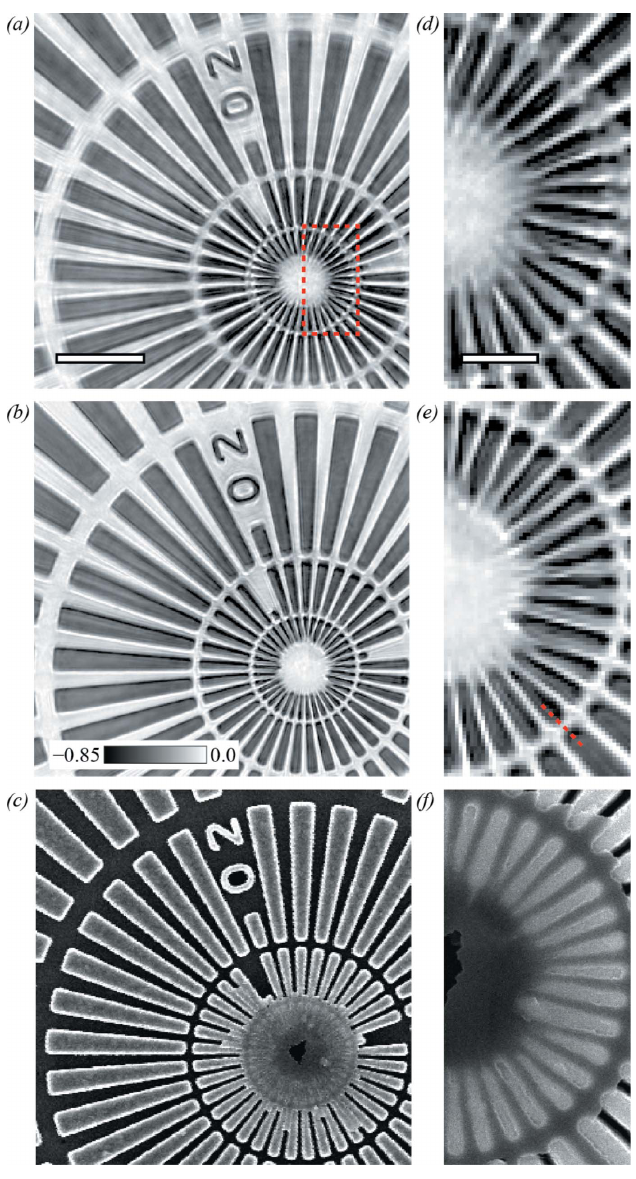
Figure 3 SXDM phase-contrast images of a test pattern for ( a ) externally triggered (ET) and ( b ) free-run (FR) data collection with interpolated positions. ( c ) An SEM image of the centre of the test pattern. Insets ( d )–( f ) are taken from the area depicted by the red box in panel ( a ), showing that FR data collection allows higher quality reconstruction of the finest details in the test object. The scale bars in panels ( a ) and ( d ) correspond to 2 m m and 500 nm, respectively, and the grey scale in panel ( b ) indicates the quantitative phase delay in radians.